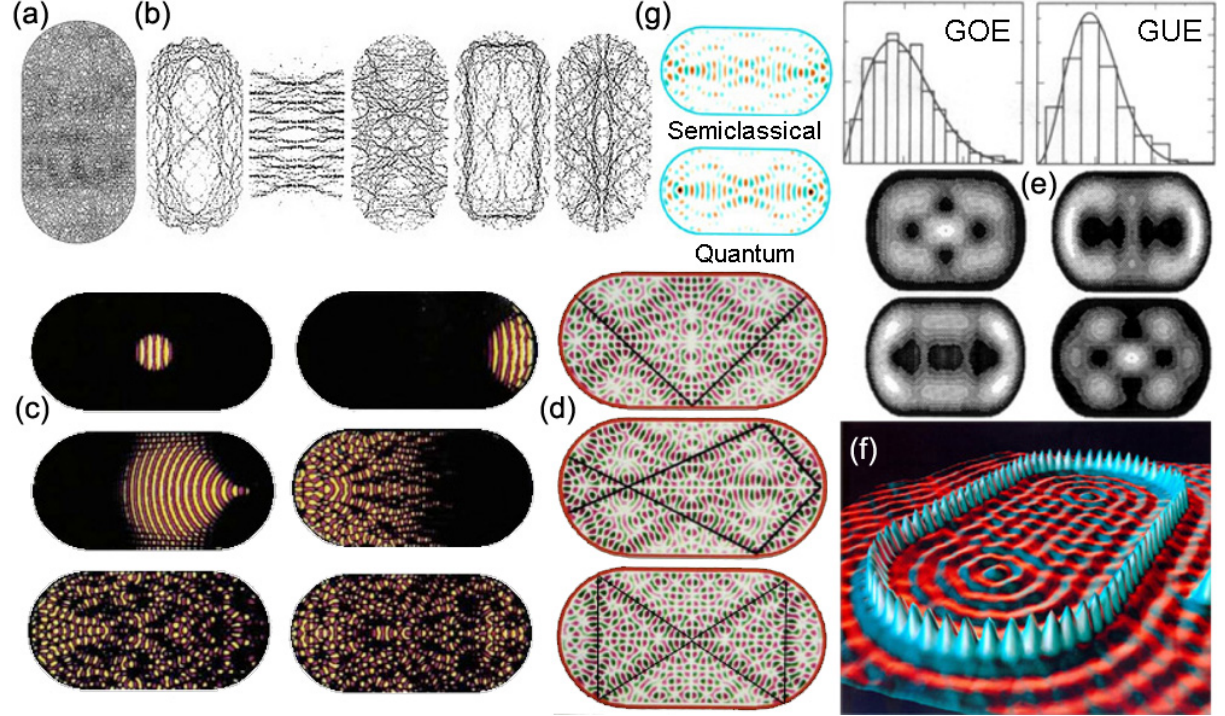
Figure 1: Quantum chaos: (a) the stadium is densely filled with repelling periodic orbits [9], three of which are shown in black in (d). The quantum solution of the stadium potential well (b) [4] and (d) [5] shows scarring of the wave function along these repelling orbits, thus repressing the classical chaos, through probabilities clumping on the repelling orbits. A semi-classical simulation (c) shows why this is so. The quantum solution is scarred on precisely these orbits (d). This causes it to coincide with the eigenfunctions of the repelling periodic orbits, just as the orbital waves of an atom constructively interfere with themselves, in completing an orbit to form a standing wave, like that of a plucked string. Over time, although the behavior may be transiently chaotic, the quantum system eventually settles into a periodic solution or a linear combination of these. Experimental realizations, such as a magnetized electron in a quantum dot (e) [10] [Gaussian orthogonal ensemble (GOE) and Gaussian unitary ensemble (GUE) statistics], or the scanning tunneling view of an electron on a copper sheet bounded by a stadium of carefully-placed iron atoms (f) [11], confirm the general picture, although quantum tunneling in the latter case leaked the wave function outside too much to demonstrate proper scarring. The semi-classical approach matches closely the quantum calculation